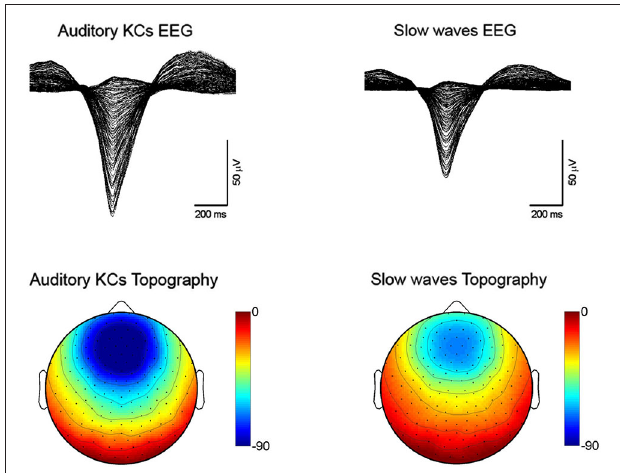
FIGURE 2 | Sleep recordings performed with a HydroCel 256 channel hdEEG net (Electrical Geodesics Inc.) using NetStation software in healthy subjects ( n = 5) . Auditory tones were delivered through speakers or headphones during N2-N3 sleep stages. Auditory KCs and slow waves were detected globally based on period-amplitude criteria (peak to peak minimum amplitude: 75 µ V; negative going zero-crossing to positive going zero-crossings greater than 250 ms and less than 1000 ms). For the KCs, an additional criterion was that the waves had to occur between 200 and 1100 ms after the auditory stimulus. Top figures are butterfly plots (all channels overlaid) averaging across all auditory evoked KCs (on the left) and all spontaneous slow waves (on the right). Both waves were aligned by the negative peak. Bottom plots show the average scalp voltage topography at the negative peak for KCs (on the left) and spontaneous slow waves (on the